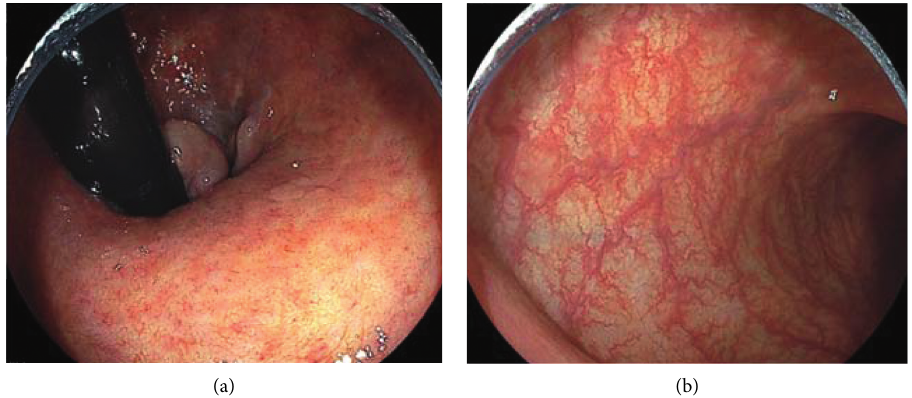
Figure 3: 25 months after treatment, endoscopic findings of the (a) rectum and (b) sigmoid colon showing normal mucosa with visible vascular pattern, consistent with endoscopic remission, Mayo endoscopic subscore (MES)